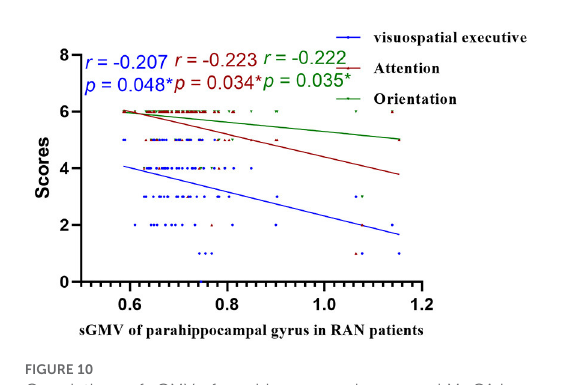
FIGURE10 Correlations of sGMV of parahippocampal gyrus and MoCA in RAN patients. RAN, right acoustic neuroma; sGMV, smoothed gray matter volume. * p <